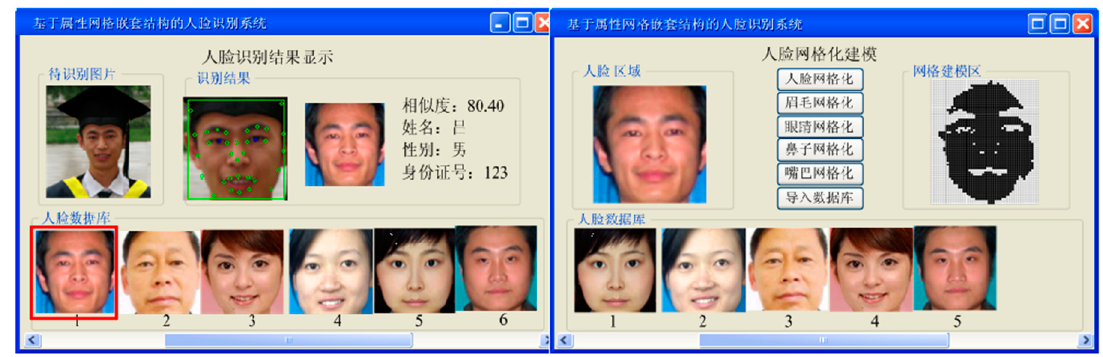
Figure 7. The decomposition of face Construction.